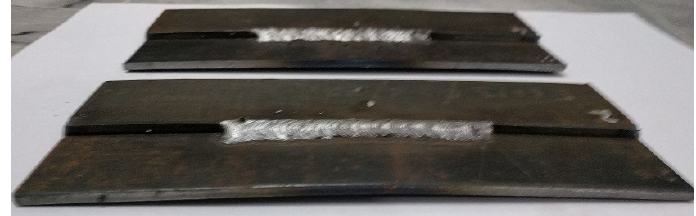
Figure 4. Test sample for calibration.